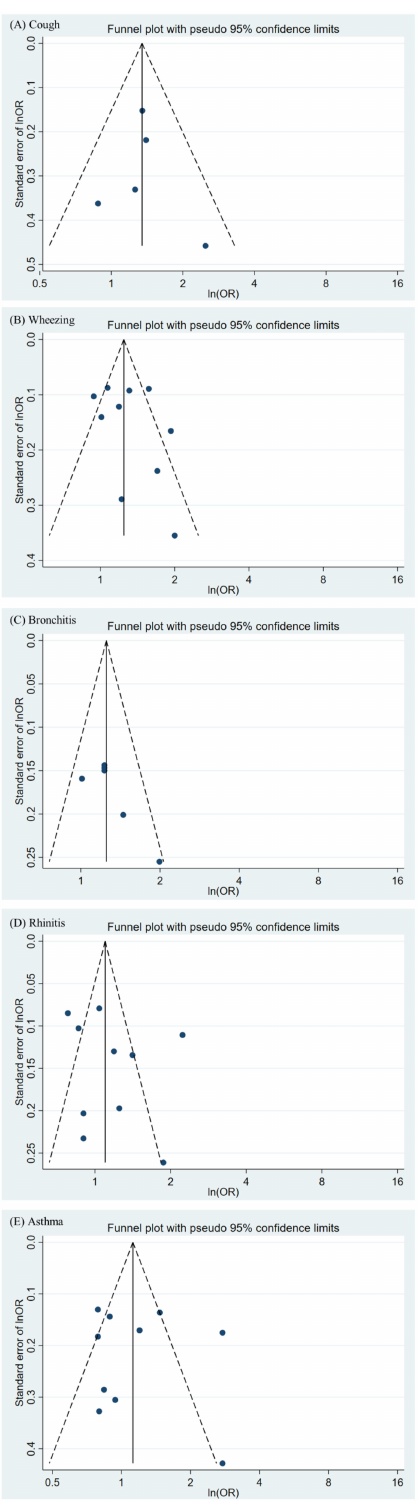
Figure 3. Funnel plot of study groups and risk of five respiratory symptoms for residents near petrochemical industrial complexes. ( A ) Funnel plot of study groups on cough; ( B ) funnel plot of study groups on wheezing; ( C ) funnel plot of study groups on bronchitis; ( D ) funnel plot of study groups on rhinitis; ( E ) funnel plot of study groups on asthma. N.R., nonreported; 95% CIs, 95% confidence